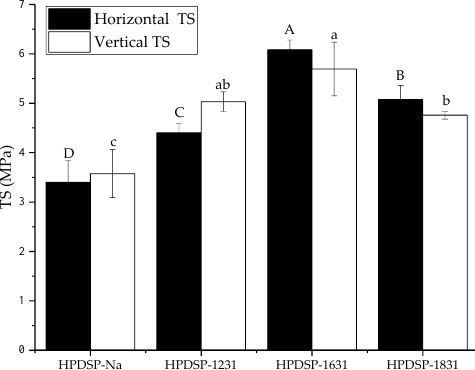
Figure 4. Horizontal and vertical tensile strength (TS) values of the HPDSP-Na and HPDSP-OMMT